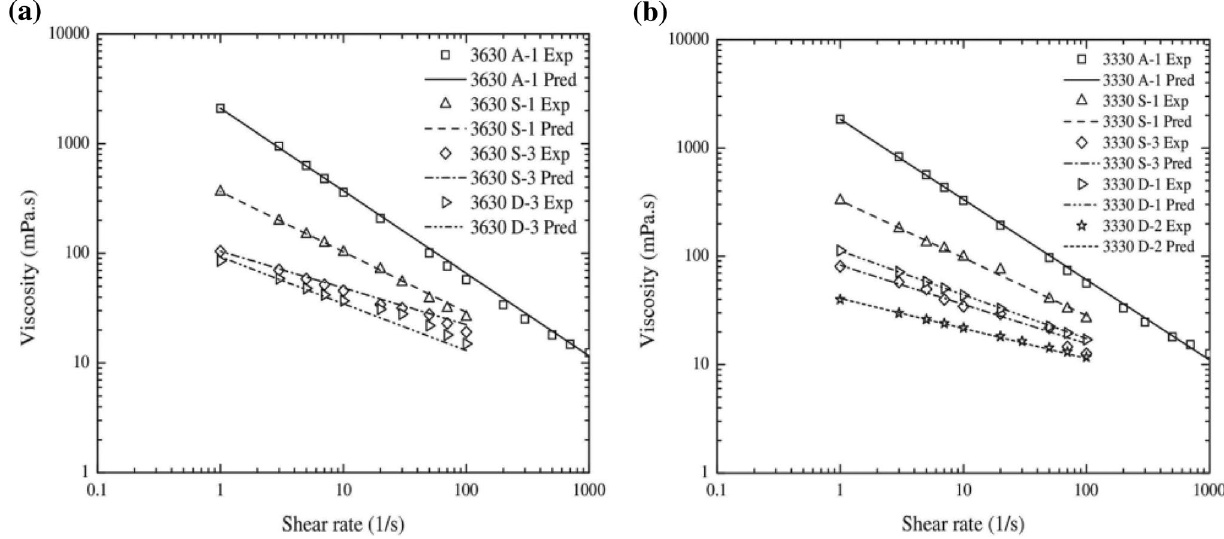
Fig. 12 Experimental and predicted HPAM viscosity match using modified power law correlation (from Hashmet et al.